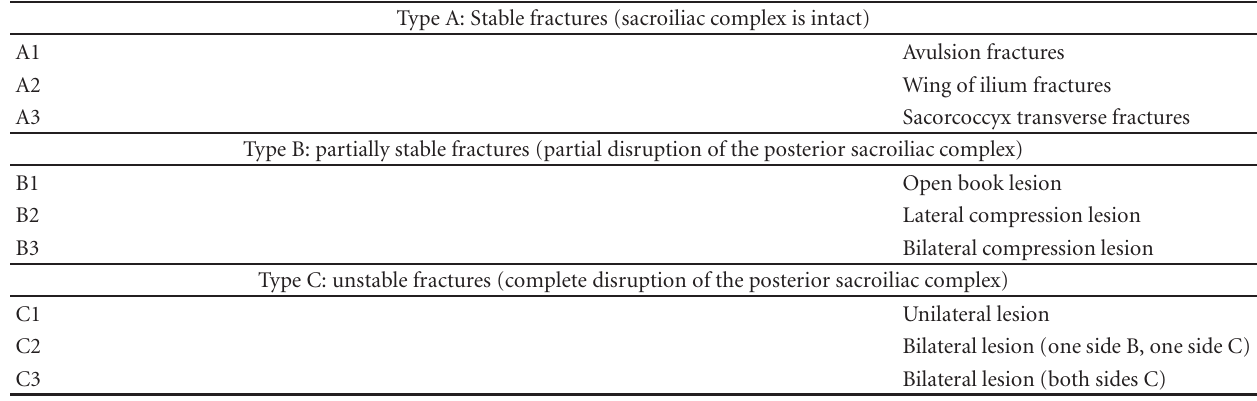
Table 2: Tile classification of pelvic injuries [22].